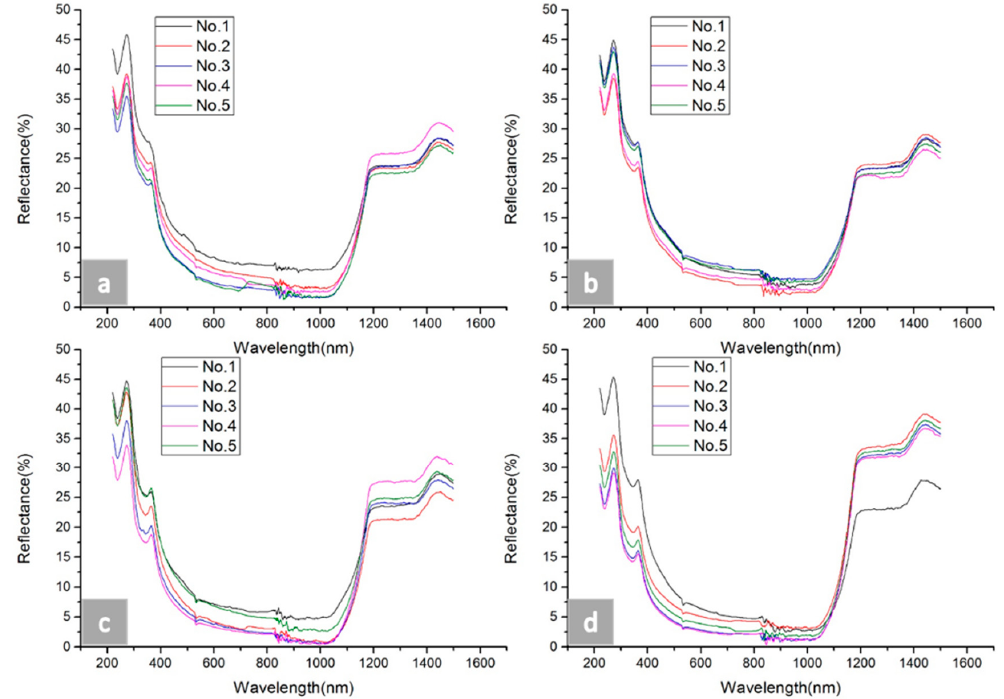
Figure 7. The hemispherical reflectance spectra of black silicon micro-nano hybrid structures obtained for different tips size structures. ( a ) The reflectance results of the five samples with #1 depth size, ( b ) the reflectance results of the five samples with #2 depth size, ( c ) the reflectance results of the five samples with #3 depth size, and ( d ) the reflectance results of the five samples with #4 depth